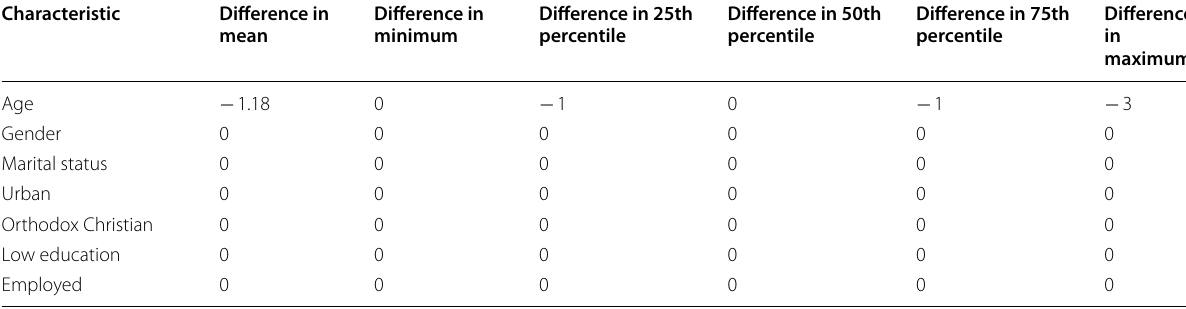
Overall L1 statistic